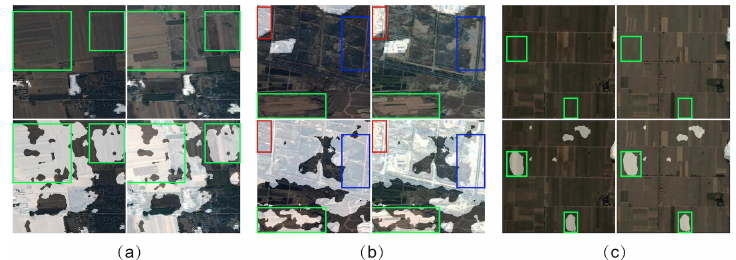
Figure 9. Samples of failure detection modes ( a – c ). We use red boxes, blue boxes and green boxes to bound the accurately detected areas, ignored labeled detected areas and wrongly detected areas, respectively.